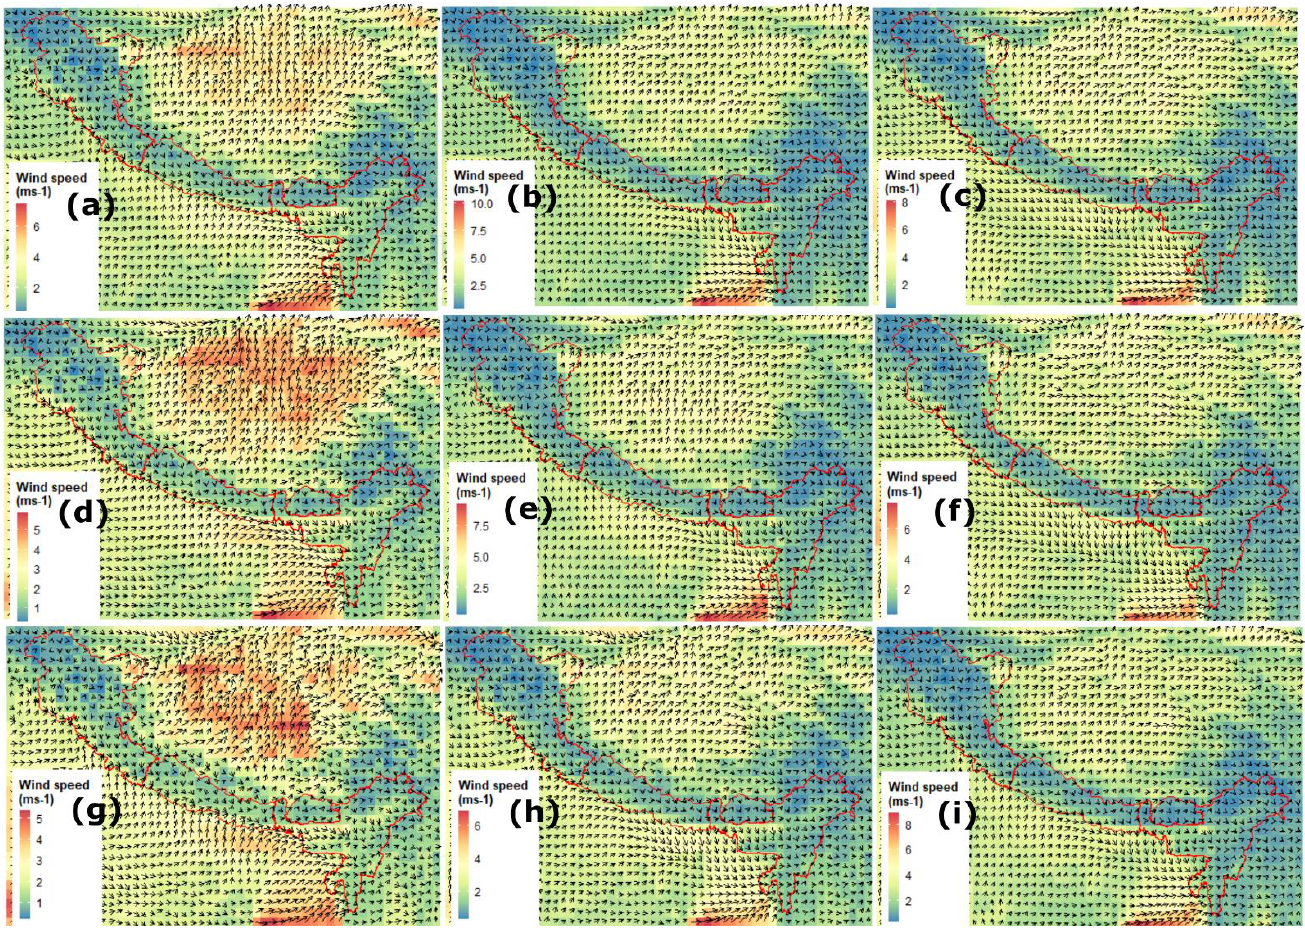
Figure 8. Wind vector plot on 1000 hPa pressure level for March, April, and May, respectively, in 2010 ( a – c ), 2016 ( d – f ), and 2018 ( g – i ).